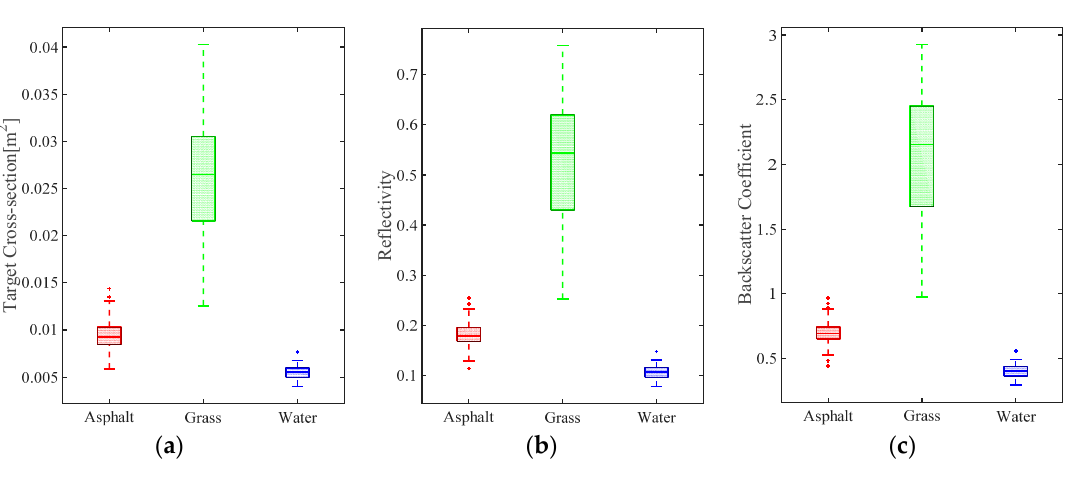
Figure 12. ( a ) Target cross-section; ( b ) the reflectance; and ( c ) the backscatter coefficient for the selected targets aggregated over different scan angles.